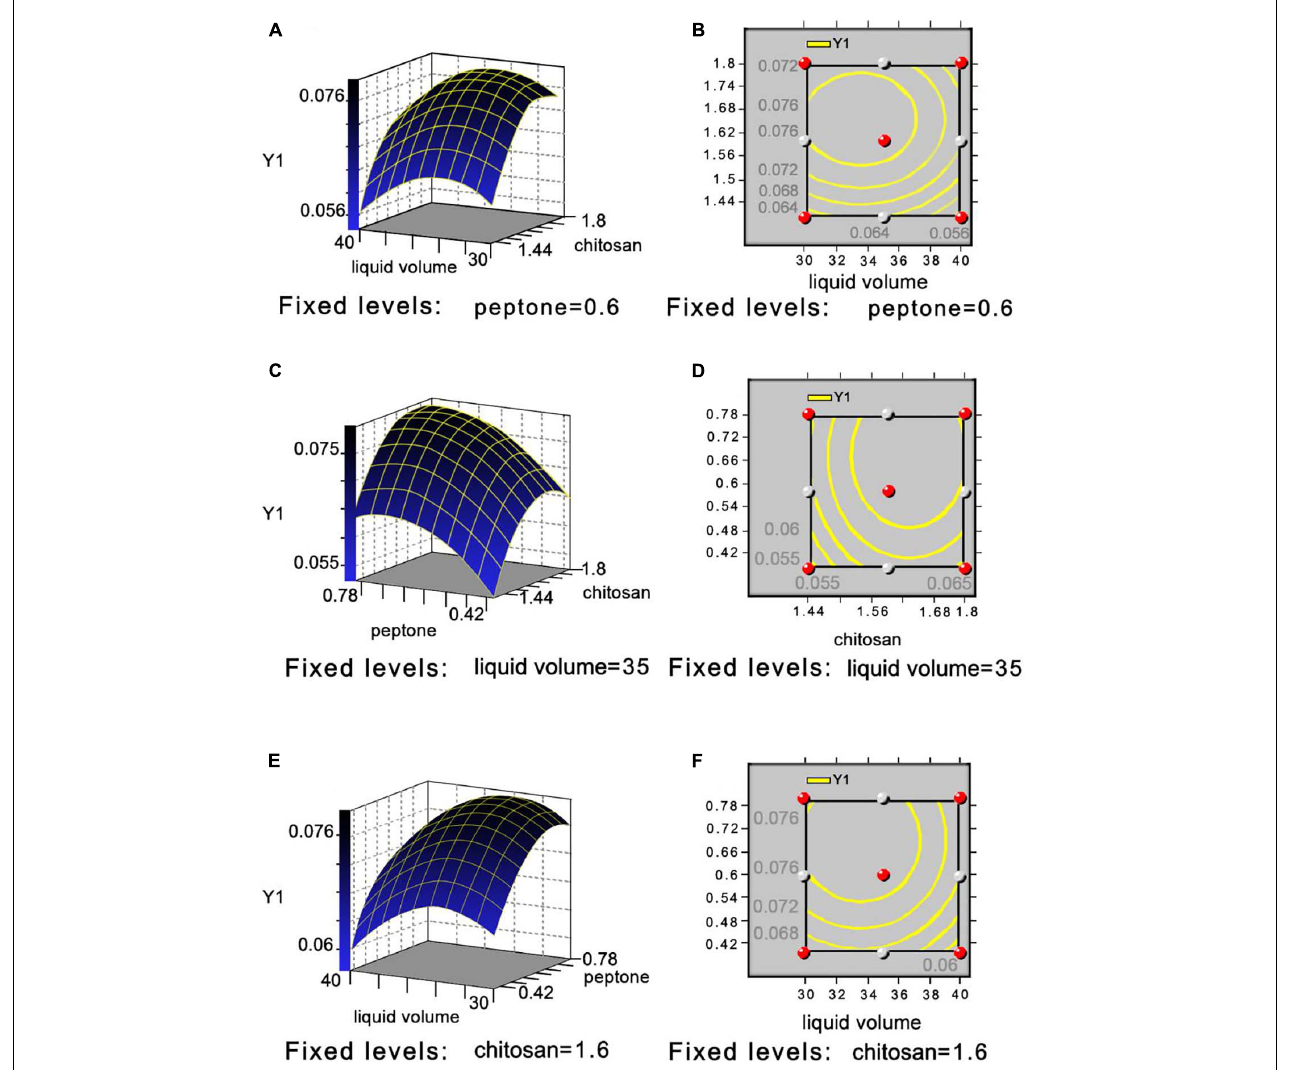
FIGURE 3 | Three-dimensional response surface and two-dimensional contour plot showing effects between liquid volume and COS (A,B) , peptone and COS (C,D) , and liquid volume and peptone (E,F) on COSE activity.